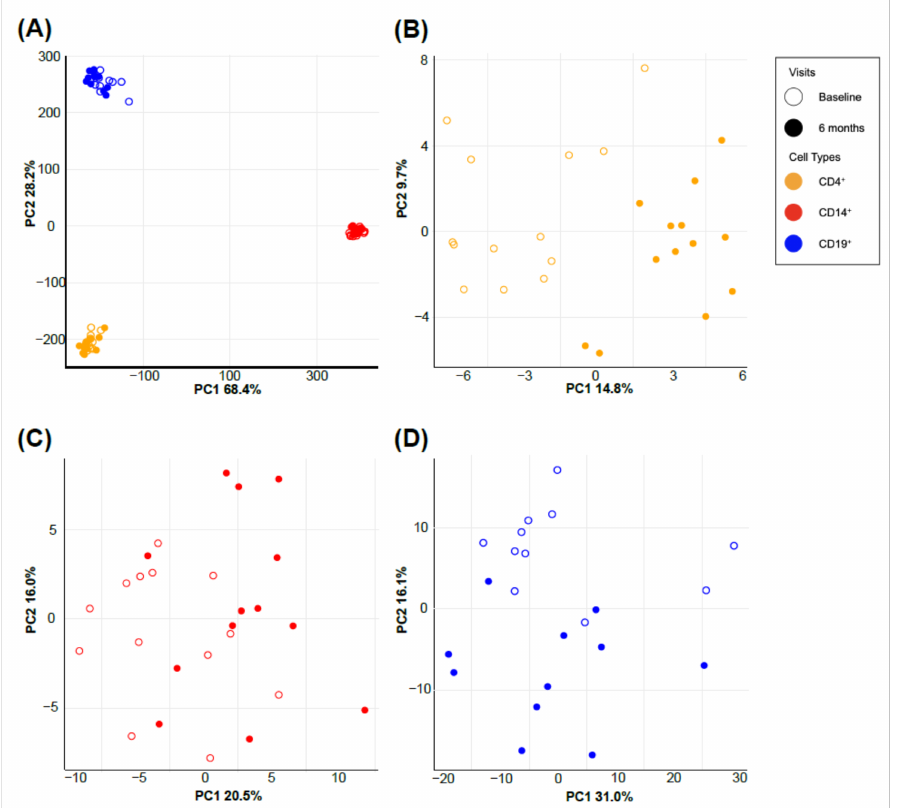
Figure 1. Gene expression profiles show distinct grouping by cell types on the principal component analysis plot. The largest source of variation from PCA is cell type ( A ). PCA plots of cell-type-specific gene expression profiles show distinctions between the periods before (baseline visit) and at the end of (6-month visit) vitamin D supplementation in CD4 + T cells ( B ), CD14 + monocytes ( C ), and CD19 + B cells ( D ). PCA, principal component